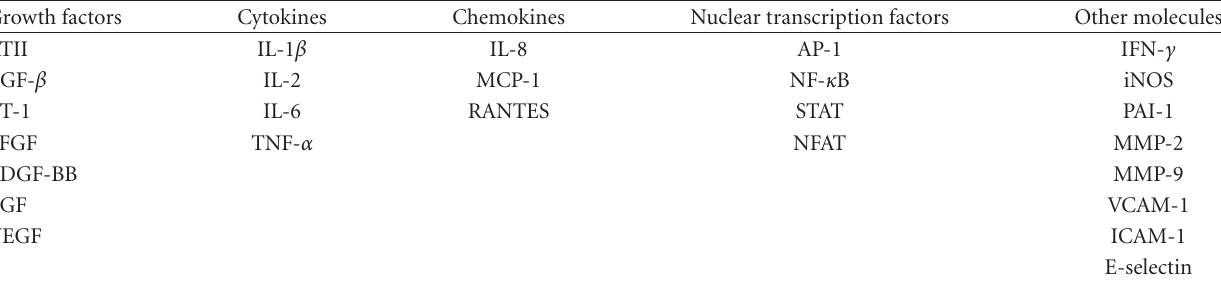
Table 2: Growth factors, cytokines, chemokines, and other proinflammatory mediators upregulated by angiotensin II stimulation. ET-1, endothelin-1; TGF- β , transforming growth factor- β ; CTGF, connective tissue growth factor; bFGF, basic fibroblast growth factor; PDGF-AA, platelet-derived growth factor-AA homodimer; EGF, epidermal growth factor; VEGF, vascular endothelial cell growth factor; IL, interleukin; GM-CSF, granulocyte-macrophage colony-stimulating factor; TNF- α , tumor necrosis factor- α ; MCP-1, monocyte chemoattractant protein- 1; MIP, macrophage inflammatory protein; NF- κ B, nuclear factor- κ B; NFAT, nuclear factor of activated T lymphocytes; STAT, signal transducer and activator of transcription; RANTES, regulated on activation, normal T-cell expressed and secreted; IFN- γ , interferon- γ ; PAI-1, plasminogen activator inhibitor type 1; AP-1, activated protein-1. (Adapted with permission from: R. E. Schmieder, K. F. Hilgers,